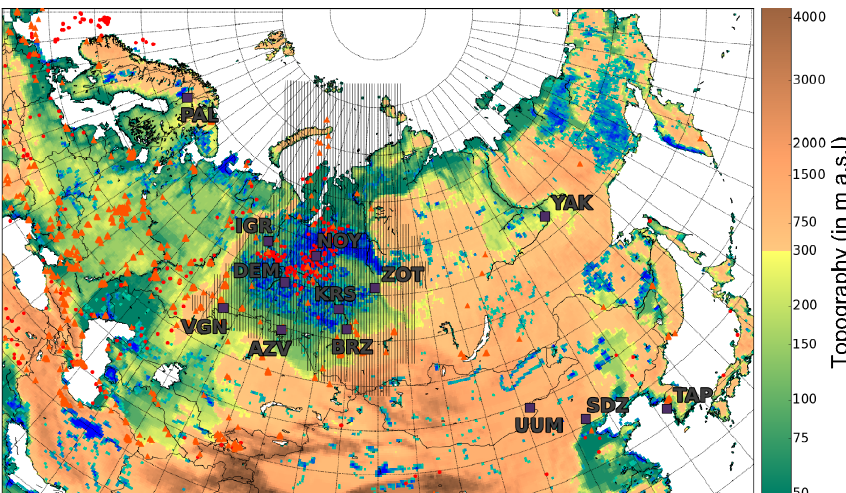
Figure 1. Topographic map of the domain of interest. The colour bar paints the altitude in metres above sea level (from ETOPO1 database; Amante and Eakins, 2009). Red dots (resp. orange triangle) depict hotspots of CH 4 emissions (based on EDGAR v4.2 inventory; see Sect. 3.3) related to oil welling and refineries (resp. gas extraction and leaks during distribution in population centres). Purple squares highlight the observation site localizations. Blueish shaded areas represent inundated regions, wetlands and peatlands (from the Global Lakes and Wetlands Database; Lehner and Döll, 2004). The Siberian budget in Sect. 5.2 is calculated on the hatched